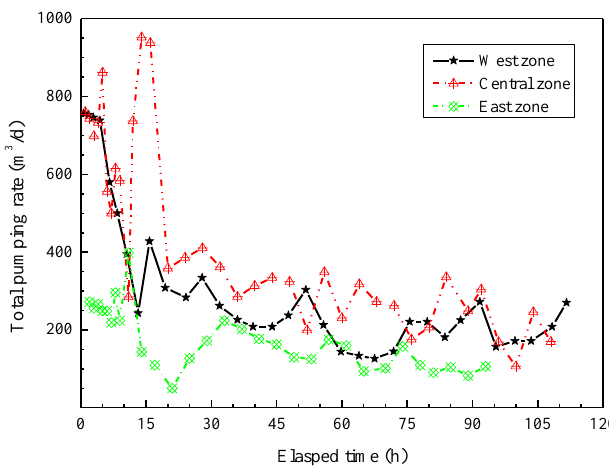
Figure 12. Time-history curves of pumping rate of wells in different excavation zone.